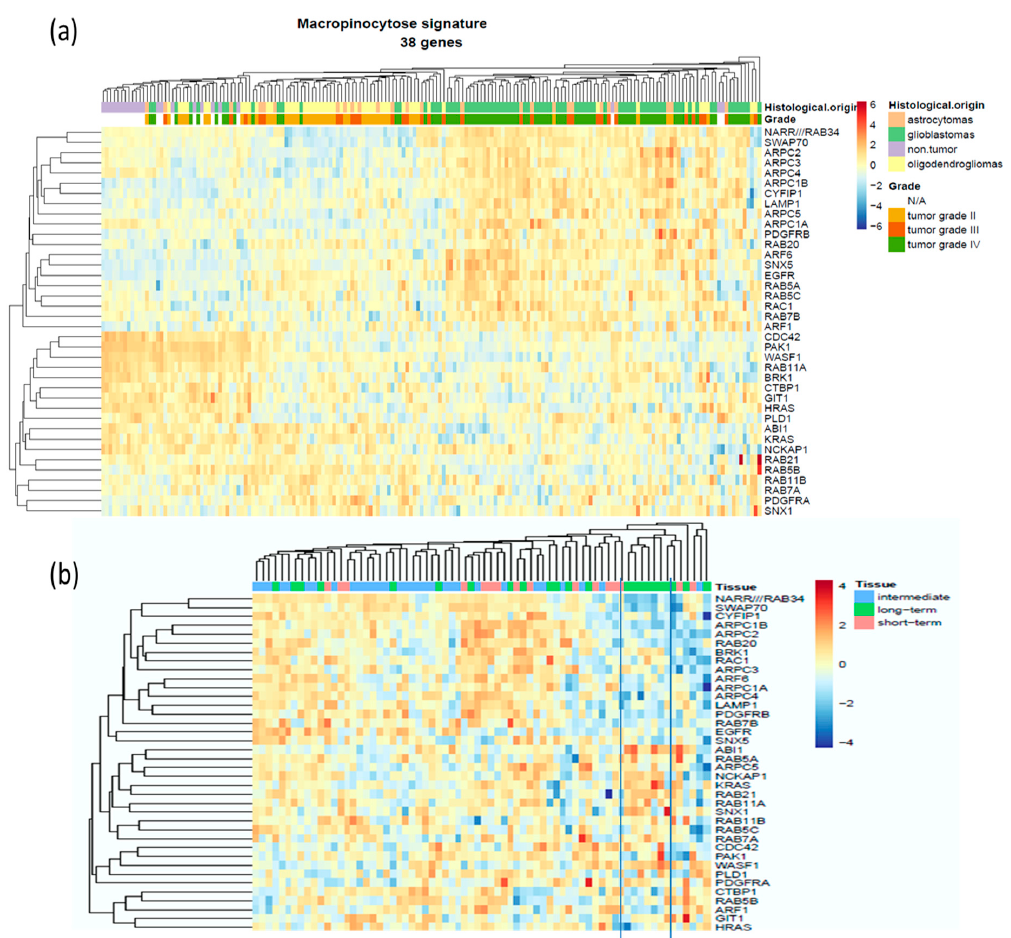
Figure 3. Heatmaps of 38 macropinocytosis gene signatures. ( a ) Dataset GSE4290 regrouping 180 samples (columns) of non-tumoral tissues (N/A) or glial tumors of various histological origin and grade according to the legend. For each gene, the data of the different probes have been averaged to be presented as a single line. Clustering has been made on the basis of the Euclidian distance. ( b ) Similar heatmap made on the dataset from GSE53733 regrouping 70 samples of GBM patients with different overall survival according to the legend. Overexpressed genes are in red, and downregulated genes are in blue (see scale next to the figures).